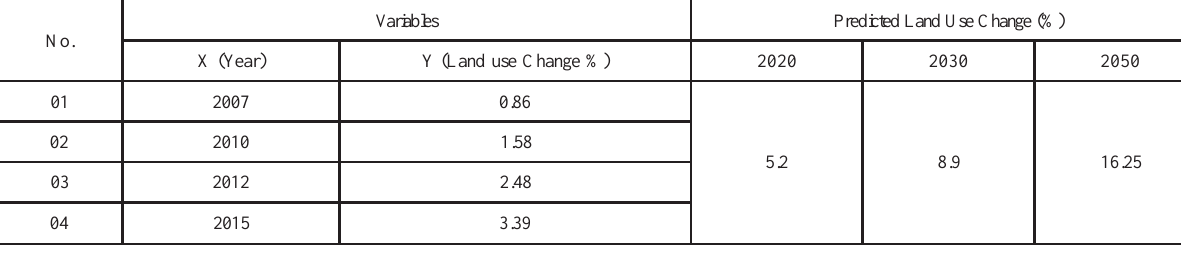
FIG. 4. GIS-BASEDLAND USE CHANGE (VERTICAL DEVELOPMENT SINCE TABLE 2. EXISTING AND PRIDICTED LAND USE CHANGE